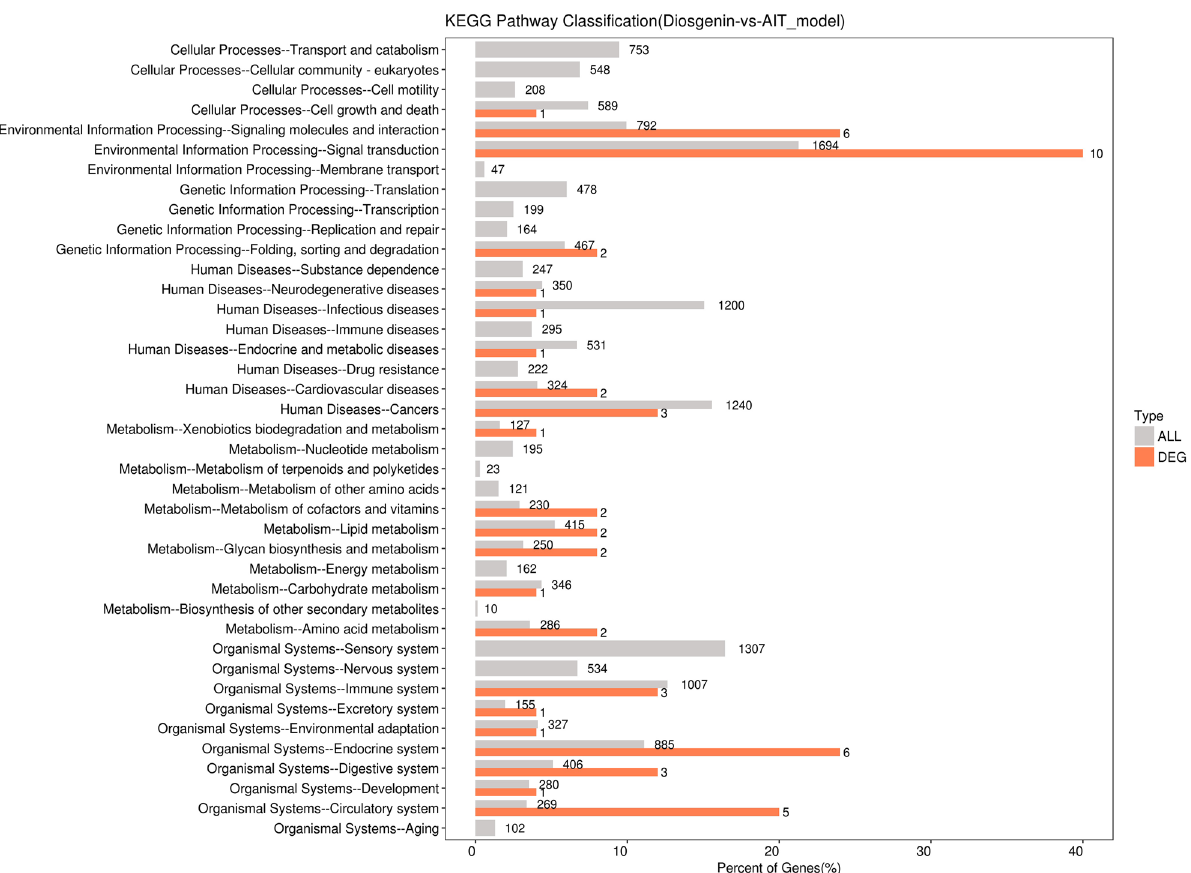
Figure 4. Comparison of differentially expressed genes (DEGs) and horizontal distribution of all genes in KEGG Level2. Photo caption: The horizontal axis is the ratio (%) of the total number of genes annotated to each Level2 metabolic pathway (DEGs) and all genes annotated to KEGG pathway (DEGs), the vertical axis represents the name of the Level2 pathway, and the number on the right side of the column represents the number of DEGs annotated to this Level2